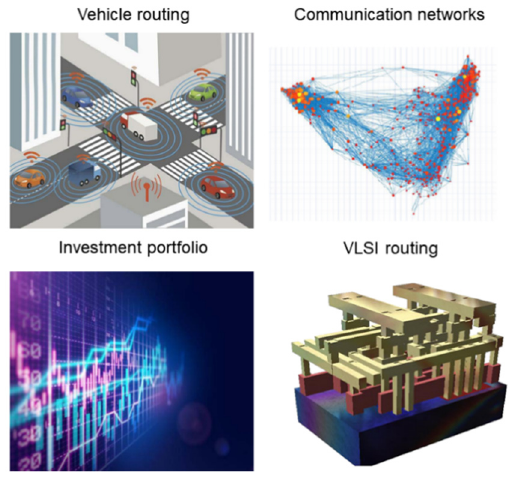
Figure 1. Applications of combinatorial optimization problems in real life [3].